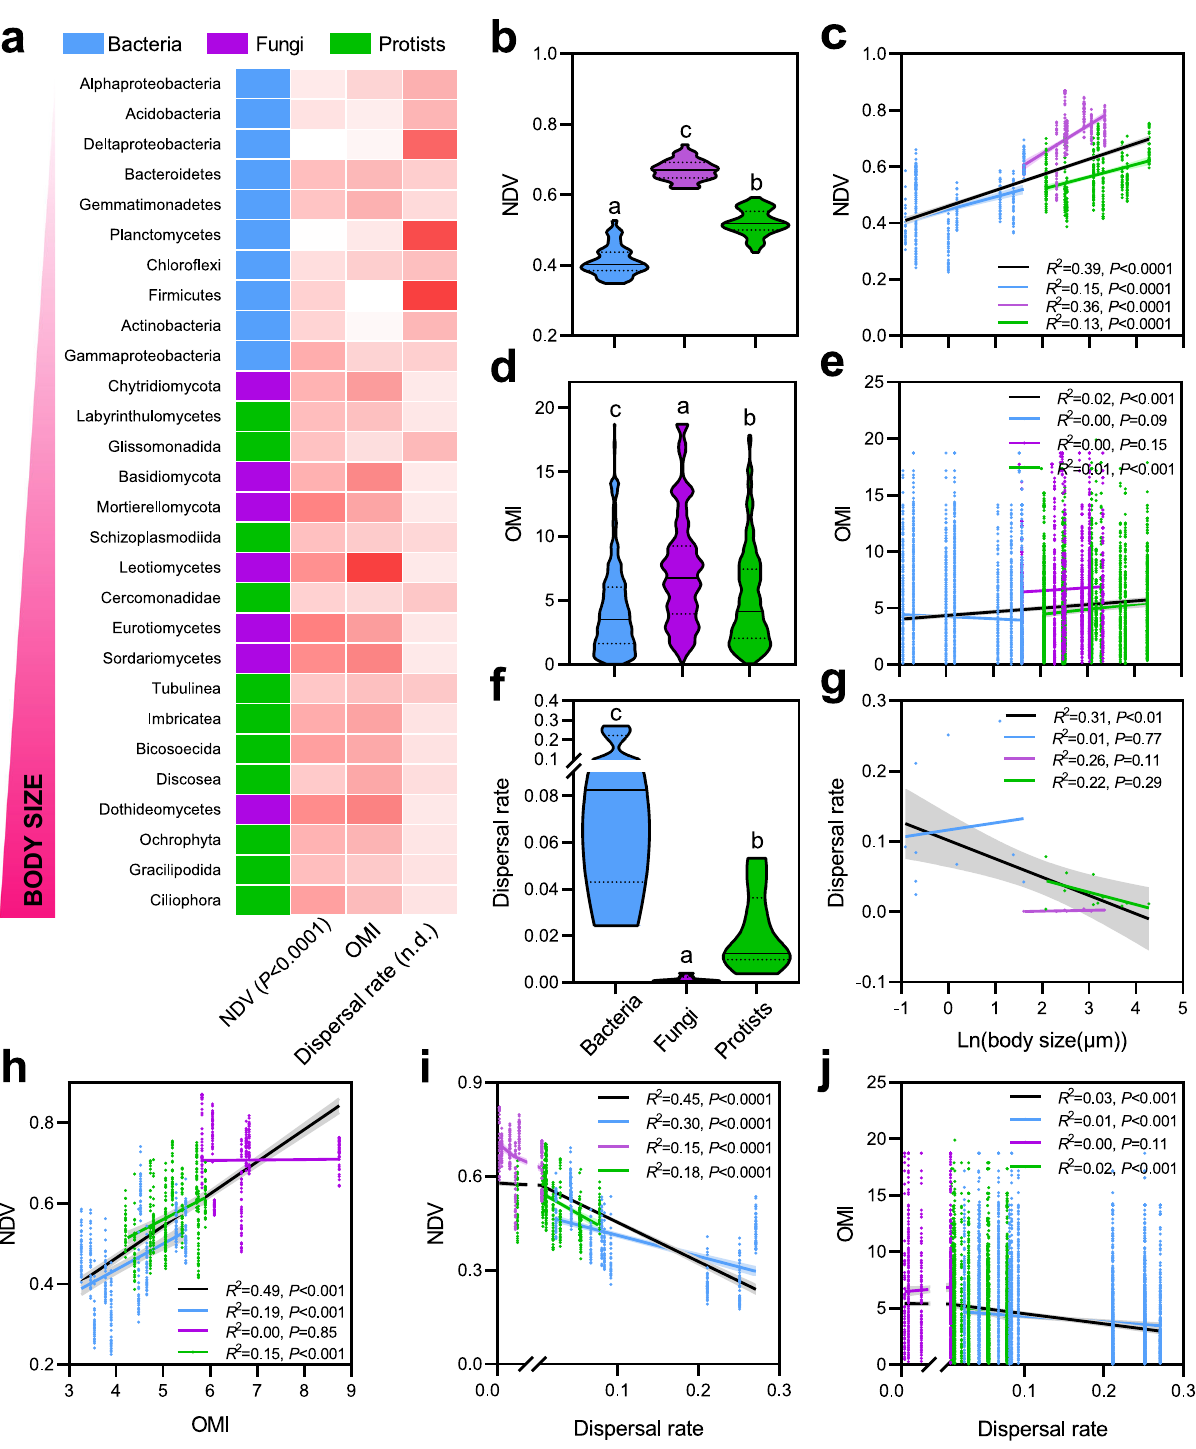
Fig. 4 Community assembly processes of soil organisms in paddy systems. a Heat map displaying the null deviation value (NDV), outlying mean index (OMI), and dispersal rate of the 28 organism groups. Darker colors indicate bigger values, and n.d. indicates absence of correlation. Violin plots displaying NDV ( b ), OMI ( d ), and dispersal rate ( f ) of bacteria, fungi, and protists. The lowercase indicates signi fi cant difference between groups ( P < 0.05) via one- way ANOVA and Tukey ’ s post-hoc tests. Correlations between the logarithm of body sizes and NDVs ( c ), OMIs ( e ), and dispersal rates ( g ); correlations between NDVs and OMIs ( h ) and dispersal rates ( i ); and correlations between OMIs and dispersal rates ( j ). Signi fi cant correlations were found using all 28 organism groups, bacterial groups, fungal groups, and protistan groups. The statistics are for the regression of all data points. Lines represent the least squares regression fi ts and shaded areas represent the 95% con fi dence intervals. We applied one-sided F test and two-sided t test, and the calculated P values as